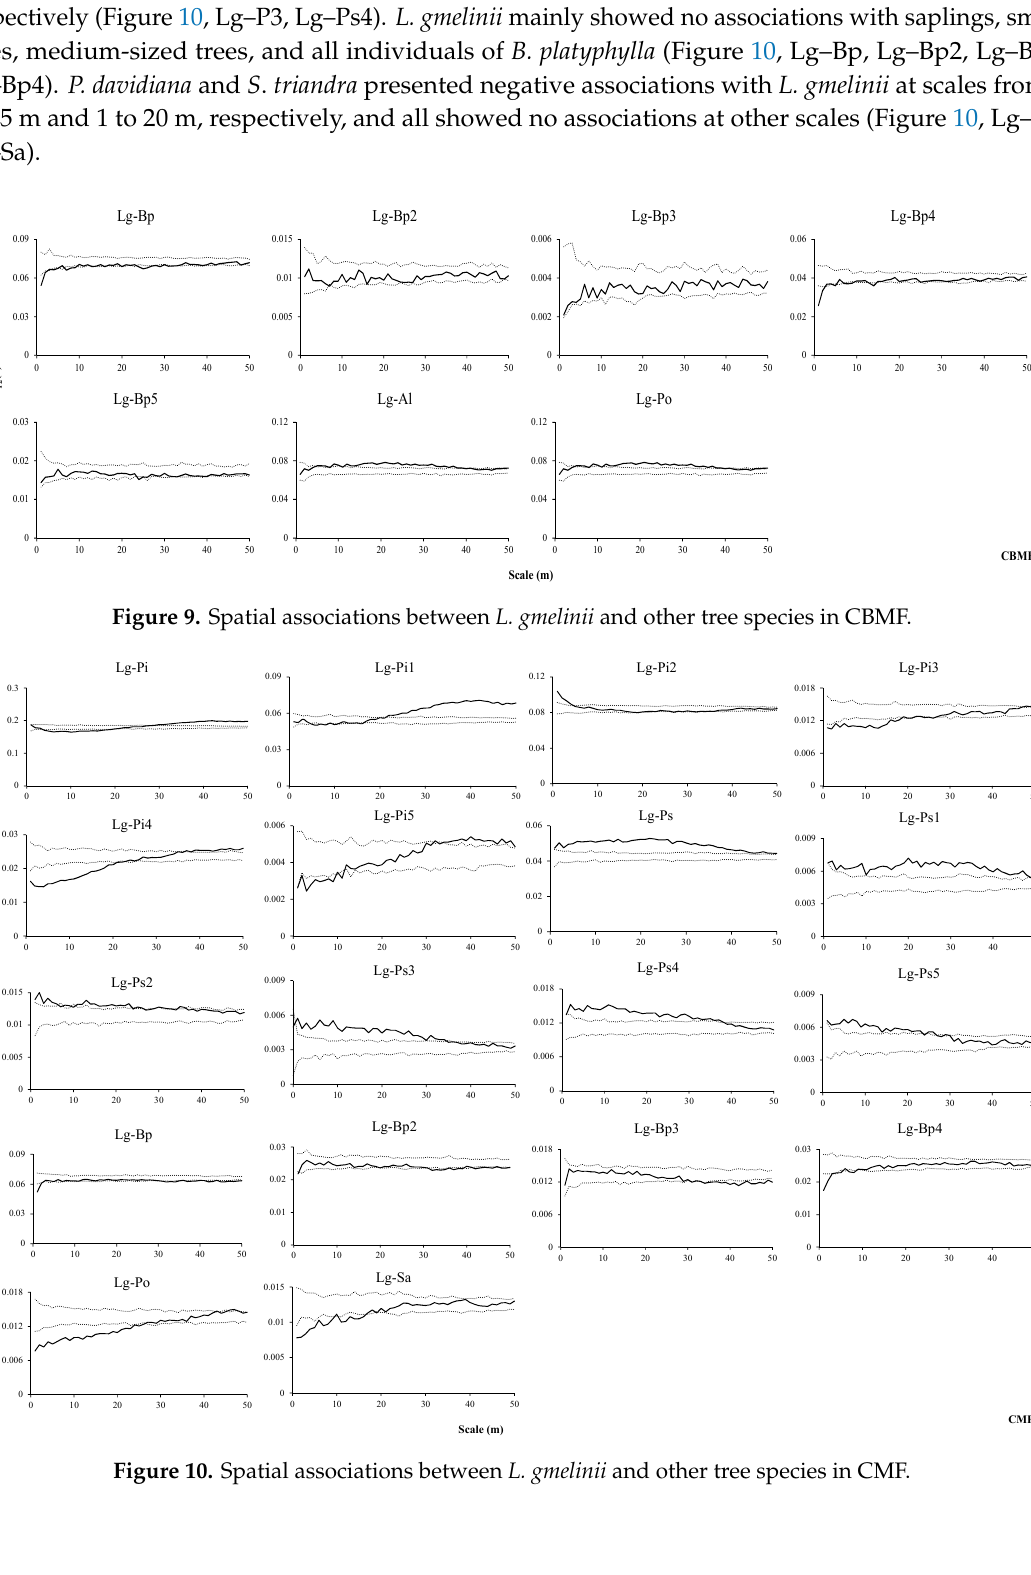
Figure 8. Spatial associations between B. platyphylla and other tree species in BF.